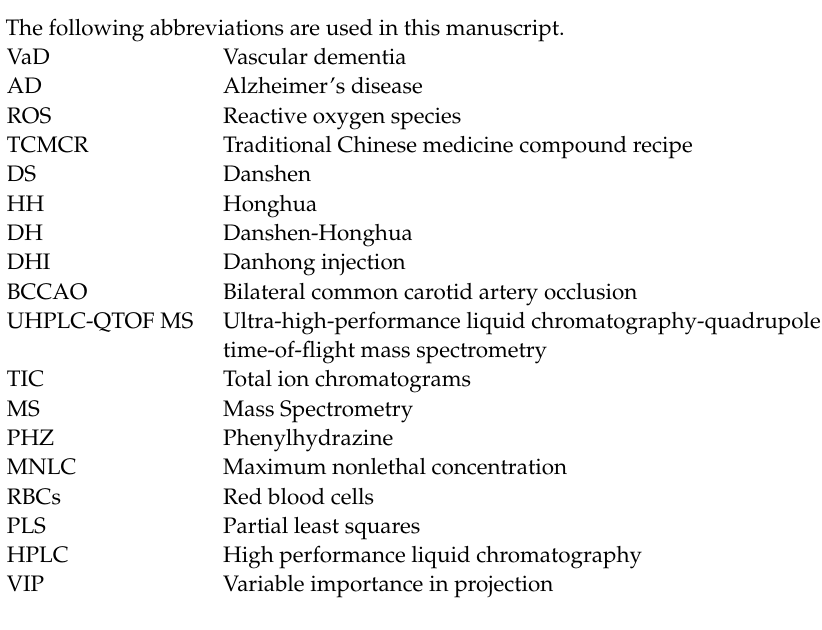
ion mode. Table S1: Death number of zebrafish in different concentrations of eight DH herbal pair in phenylhydrazine (PHZ)-induced thrombosis model. Table S2: Death number of zebrafish in different concentrations of DH herbal pair in bisphenol F (BPF)-induced neuronal injury model. Table S3: Death number of zebrafish in different concentrations of eight DH herbal pair in a ponatinib-induced ischemic stroke model. Table S4: Standard curves, limits of detection, limits of quantification, precision (intra-day, inter-day), repeatability, stability, and accuracy for the 11 components